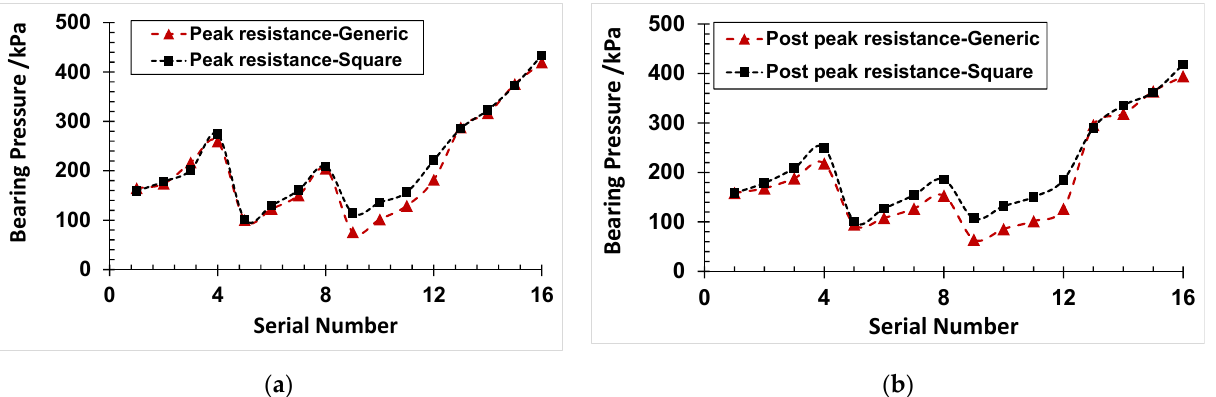
Figure 6. Comparison of the peak and post-peak resistance of the generic and cubic spudcans: ( a ) peak resistance; ( b ) post-peak resistance.